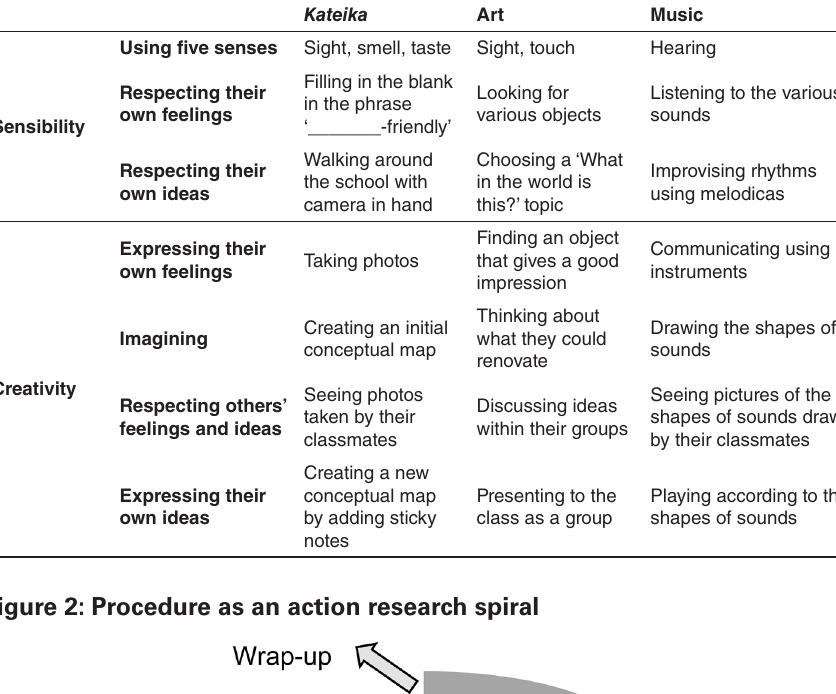
Table 2: Relations between sensibility, creativity, and curriculum content